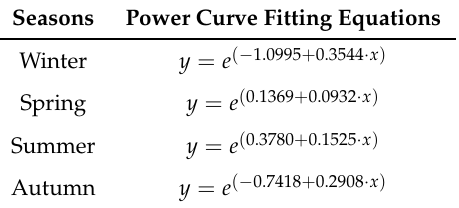
Table A2. Exponential model equations.